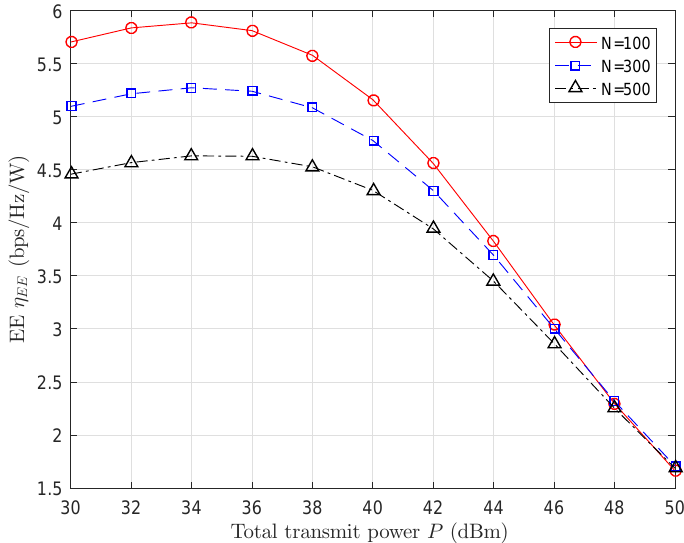
Figure 4. The energy efficiency versus the total transmit power.